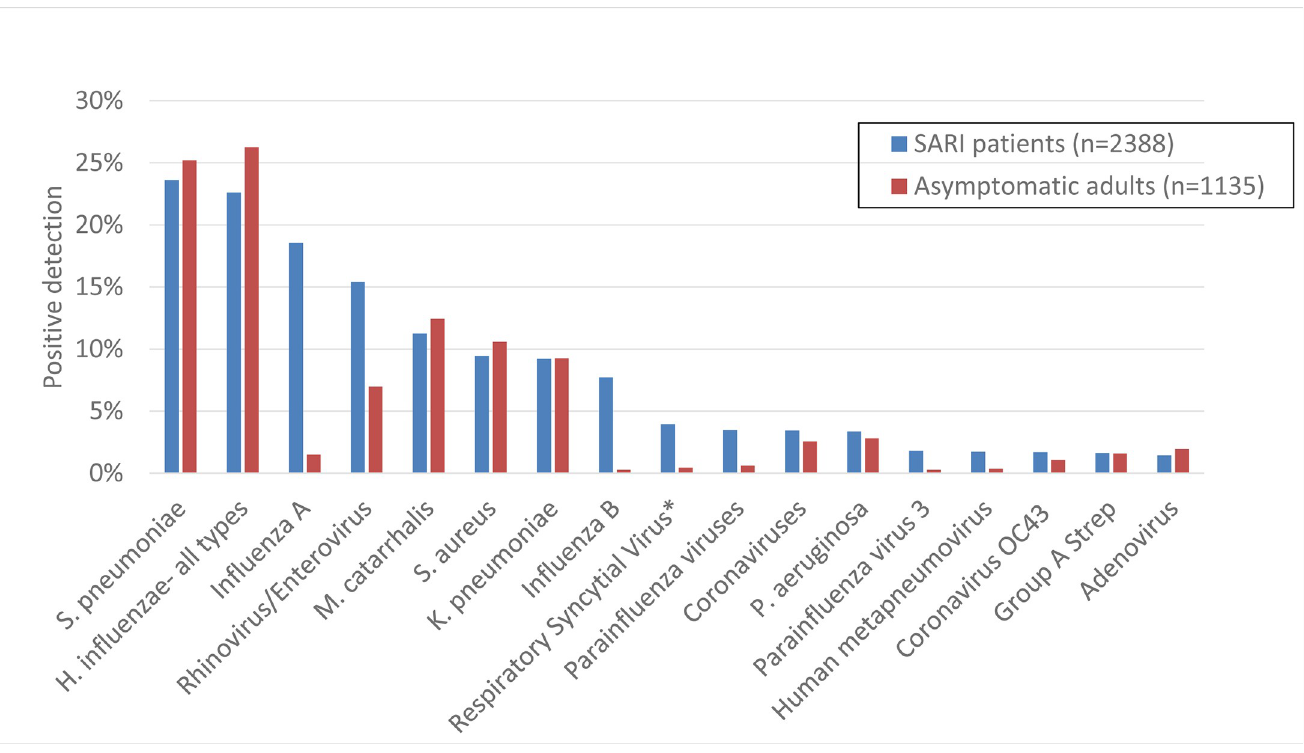
Fig 2. Percentage of severe acute respiratory infection (SARI) patients and asymptomatic adults with positive detections by pathogen, all sites. � RSV excluded in China due to contamination. Pathogens comprising < 1% of detections are not